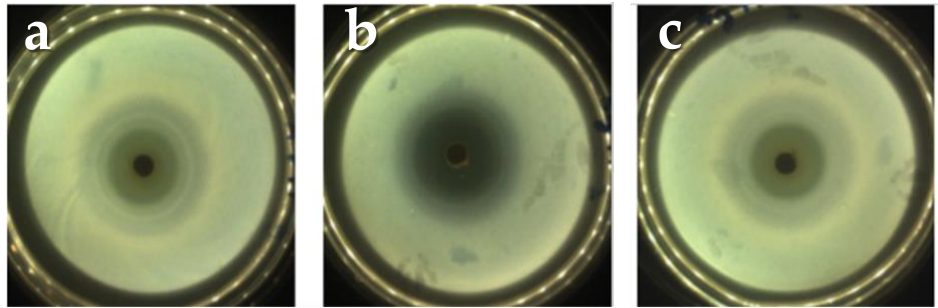
Figure 5. Diameters of the inhibition halos from the A2T1 sample at: ( a ) 24 h, ( b ) 48 h and ( c ) 72 h. The other sample (A5T1) shows a similar behavior.